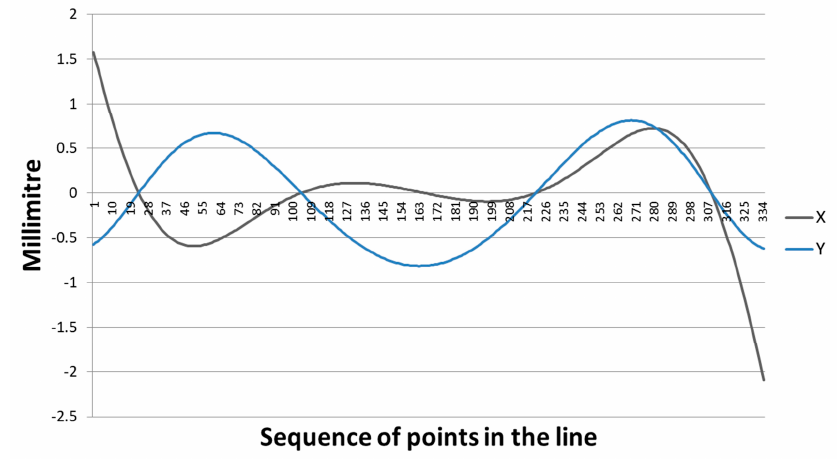
Figure 10. Residuals in the XY coordinates resulting from the circle fitting by least squares adjustment.